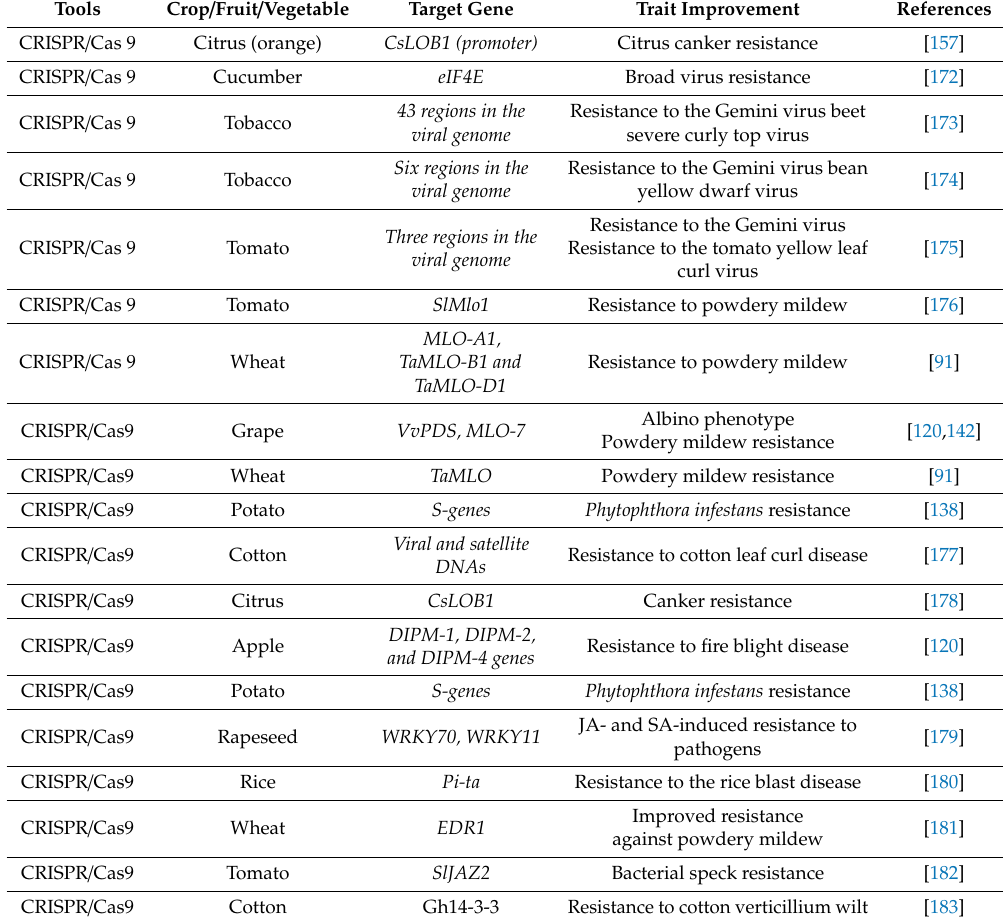
Table 5. Improvement of plant disease resistance by CRISPR in crops, fruits, and vegetables.